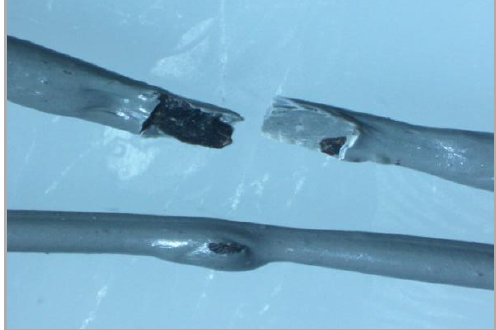
Figure 10. Impurities contained in the extruded filament.